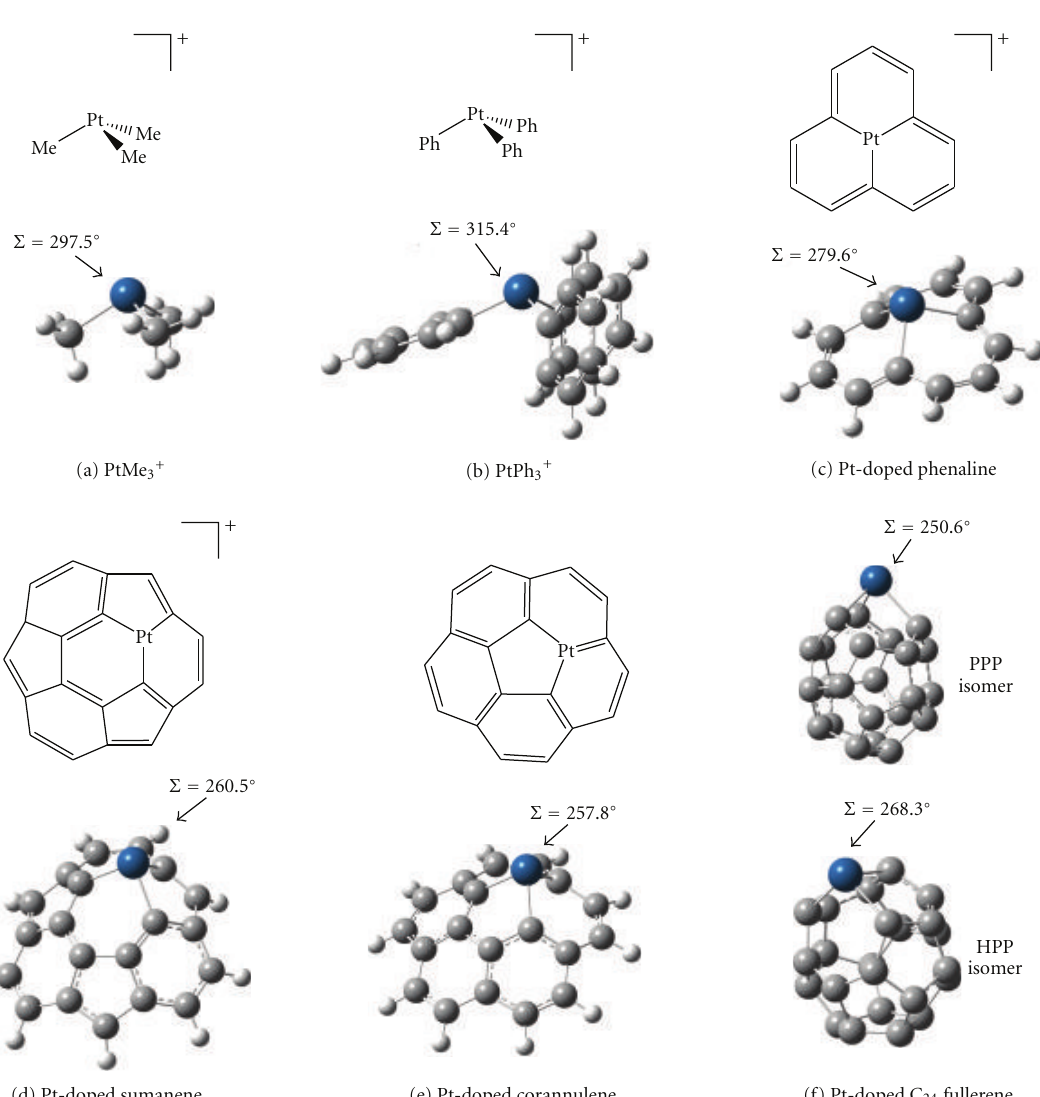
Figure 28: Optimized geometries of model alkyl- and arylplatinum complexes